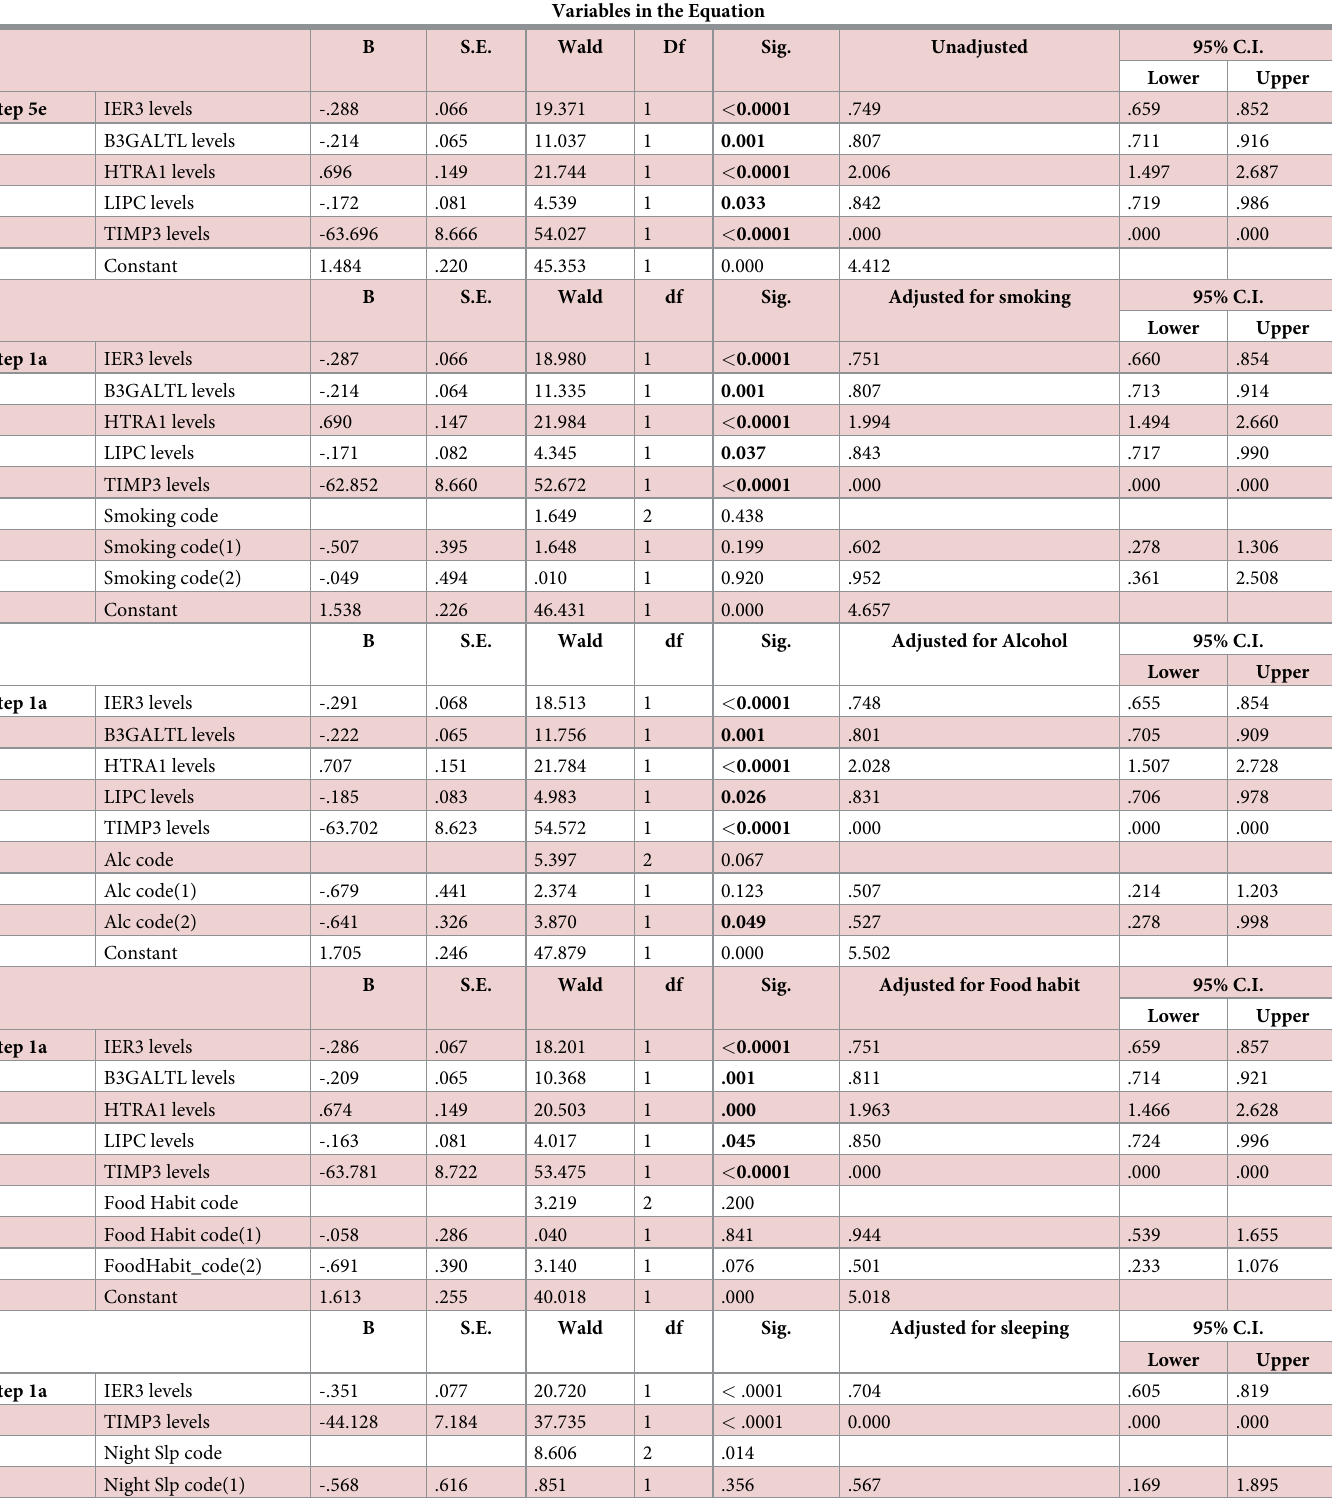
Table 4. Logistic regression analysis to estimate the changes in protein expression under the influence of ADL. Variables in the Equation B S.E. Wald Df Sig. Unadjusted 95% C.I.